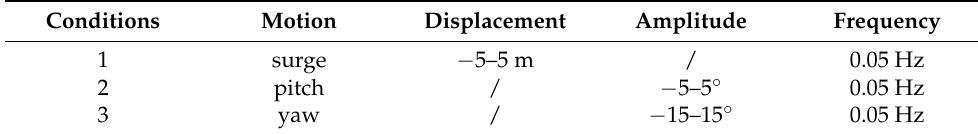
Figure 3. Computational mesh; ( a ) External domain; ( b ) Internal domain; ( c ) Hub surface mesh; ( d ) Blade surface mesh. Table 1. Floating foundation motion